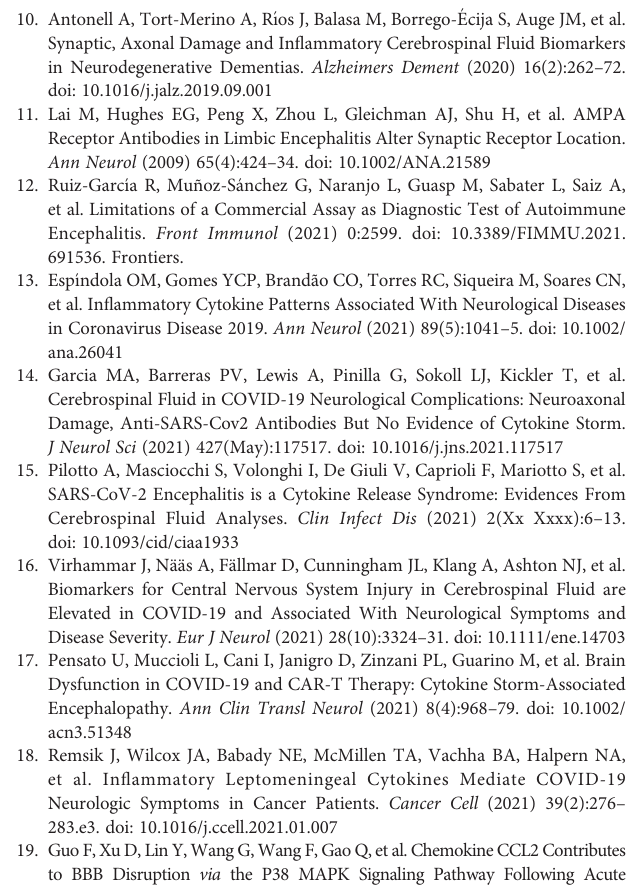
status, usingsame criteria as Table 1 . Supplementary Figure 1 | Hierarchical clustering of patients according to cytokine levels in CSF (A) and serum (B) using ClustVis (https://biit.cs.ut.ee/